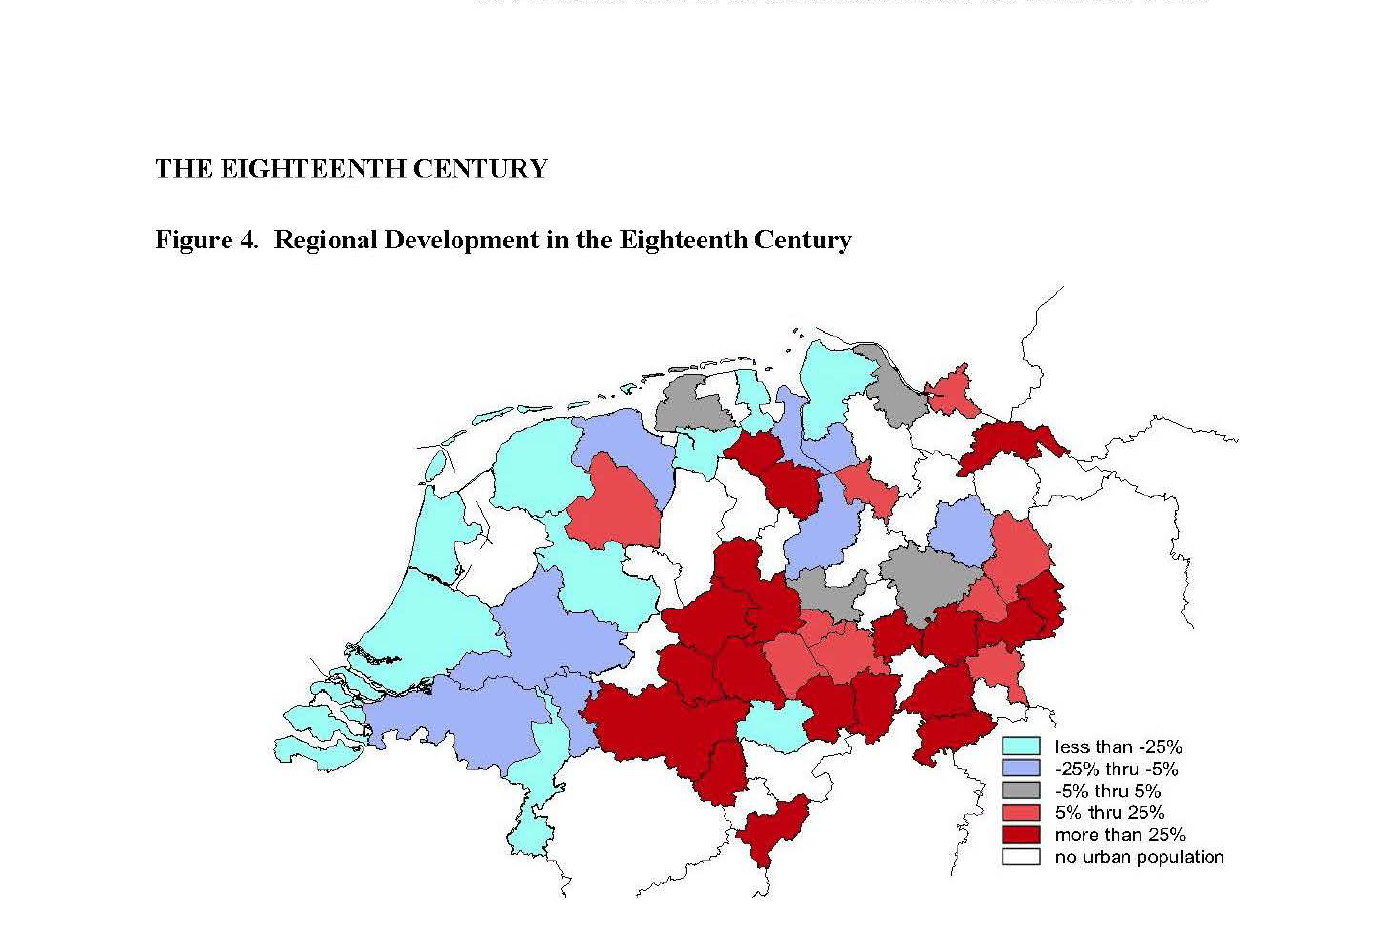
Figure 4. Regional Development in the Eighteenth